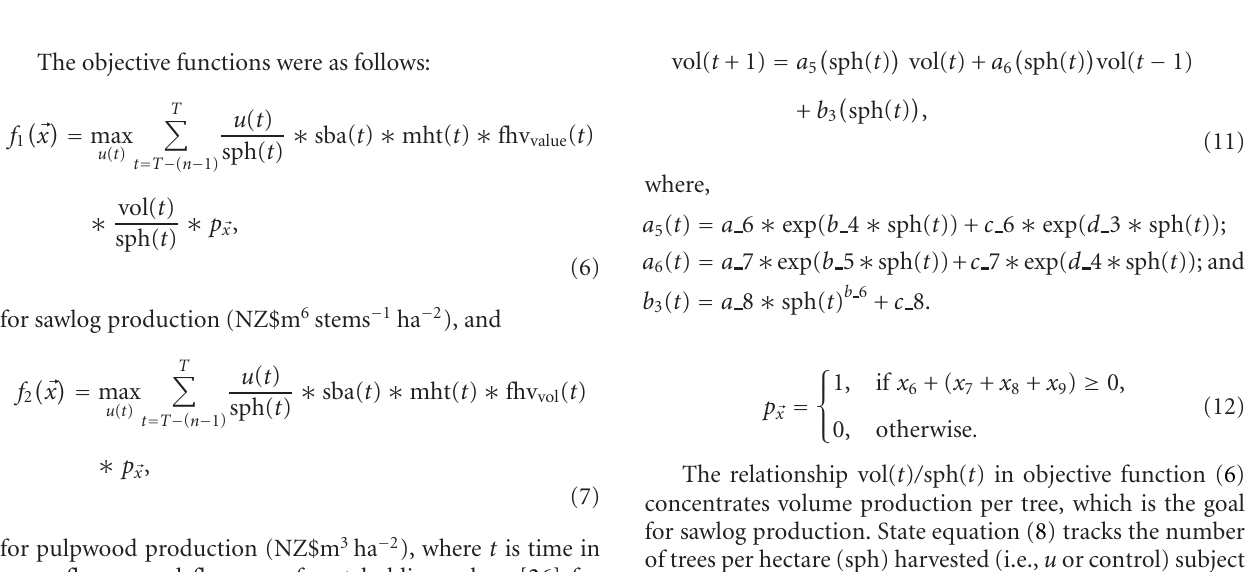
Figure 2: Decision variables with their ub and lb for each chromosome in the MOEA